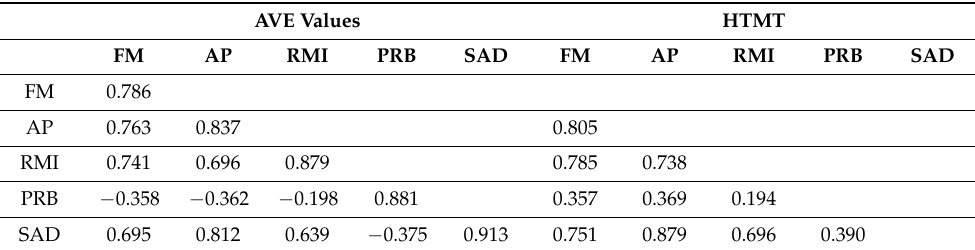
Table 3. AVE values and HTMT